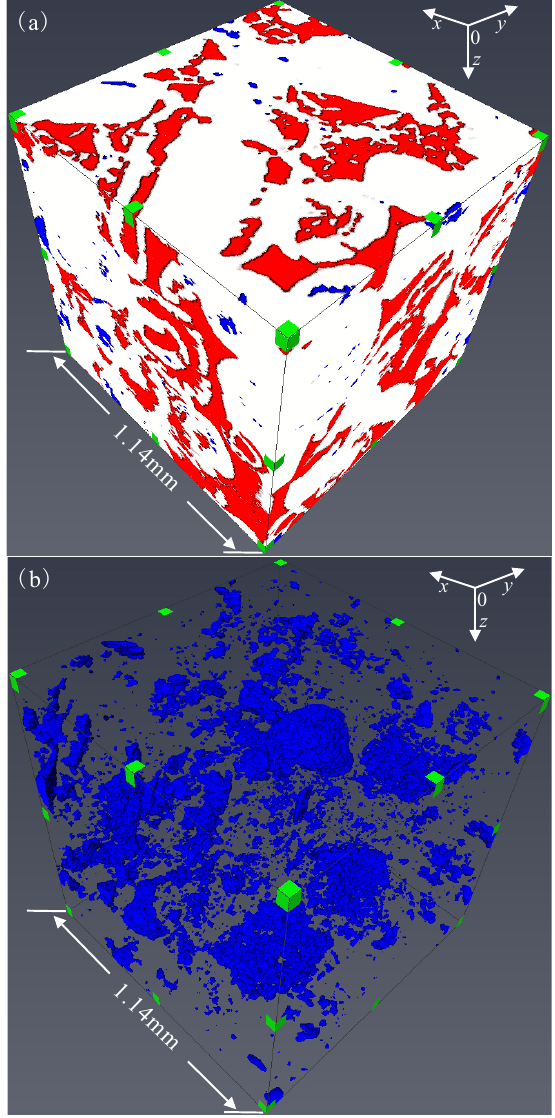
Figure 10. ( a ) The schematic of 3D micro CT image of C1, the red part represents the connected pores and the blue part represents the isolated pores. ( b ) The isolated pore space of C1.